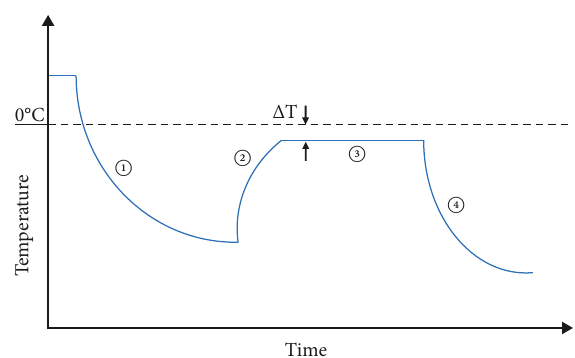
Figure 3: Cooling-freezing curve of supercooled water